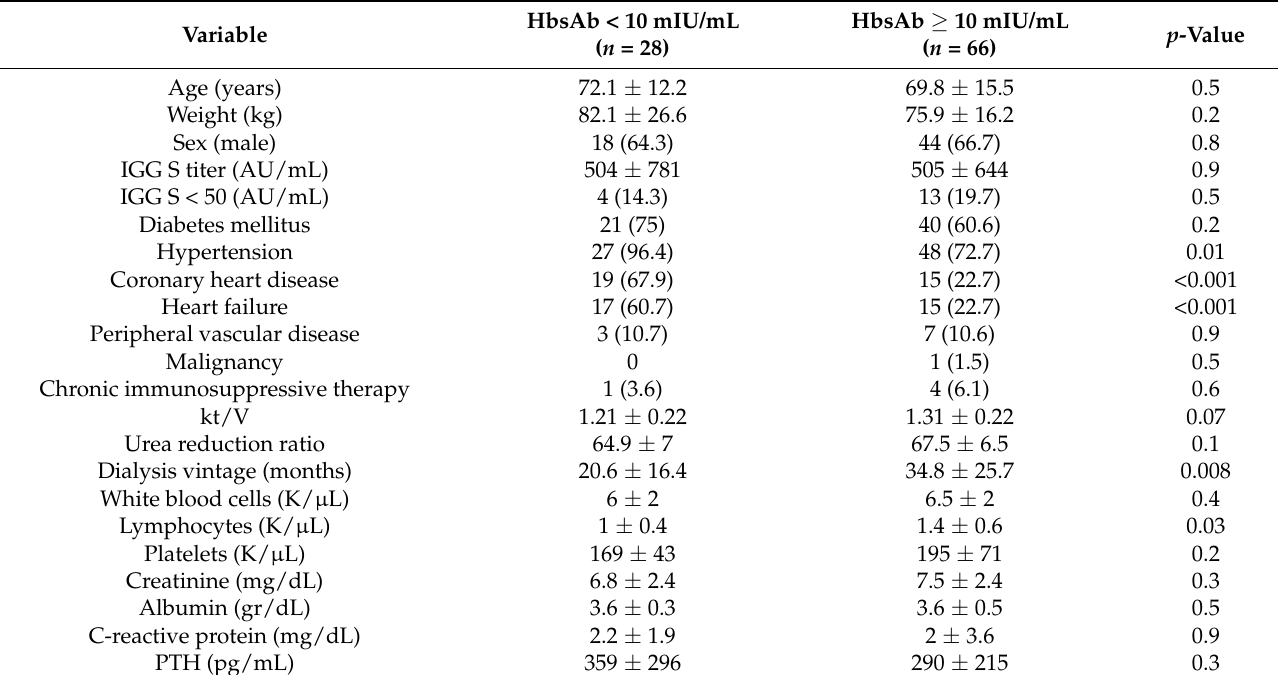
Figure 1. Study cohort.